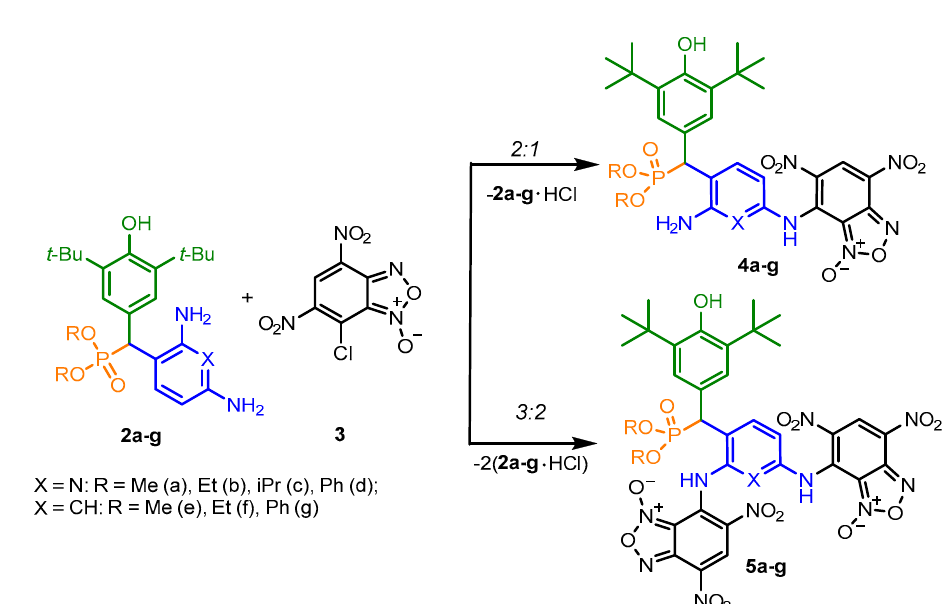
Scheme 2. Synthesis of SHP/furoxan hybrids of varying